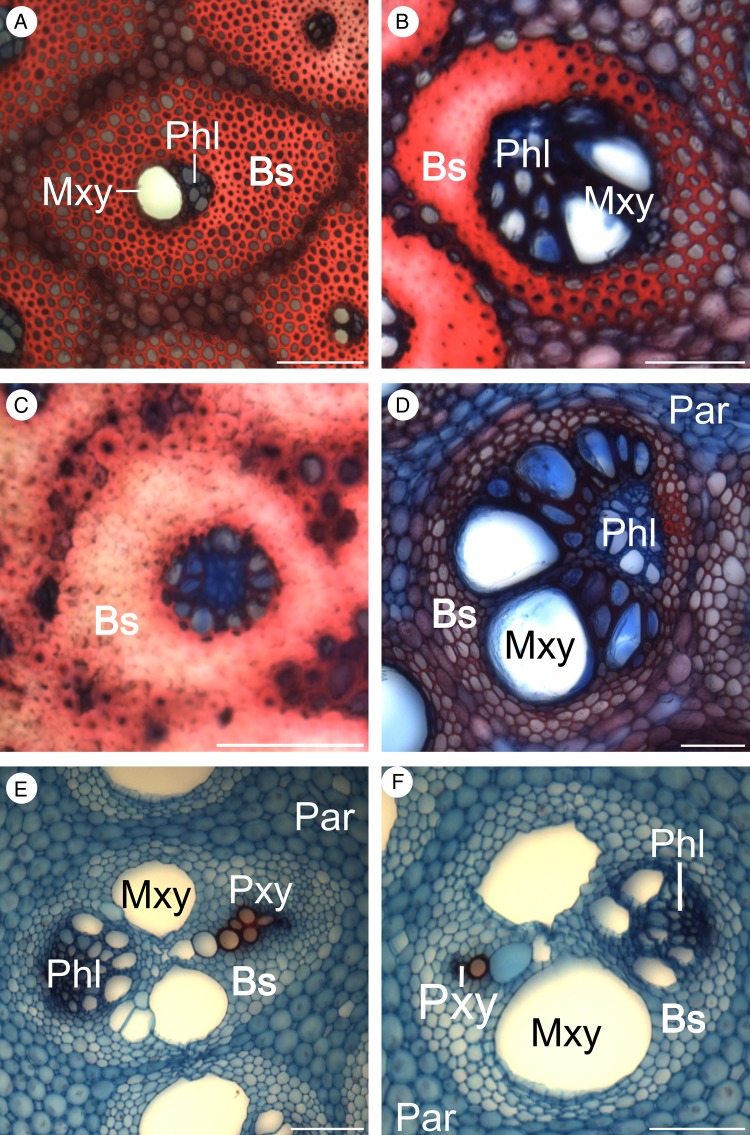
Variation of vascular bundles. (A and C) Vascular bundles of the peripheral region, with abundant and strongly lignified bundle sheaths, as well as reduced conductive tissues. (B and D) Vascular bundles at the transition zone of peripheral and central region. (B) shows higher bundle sheath density towards the periphery. (D) is characterized by a large number of conductive elements. (E and F) Vascular bundles of the central region of a young stem fragment differing in shapes from oval to circular, and having a large amount of non-lignified cells. Par, parenchyma; Phl, phloem; Pxy, protoxylem; Bs, bundle sheath; Mxy, metaxylem. Scale bars are 100 µm.